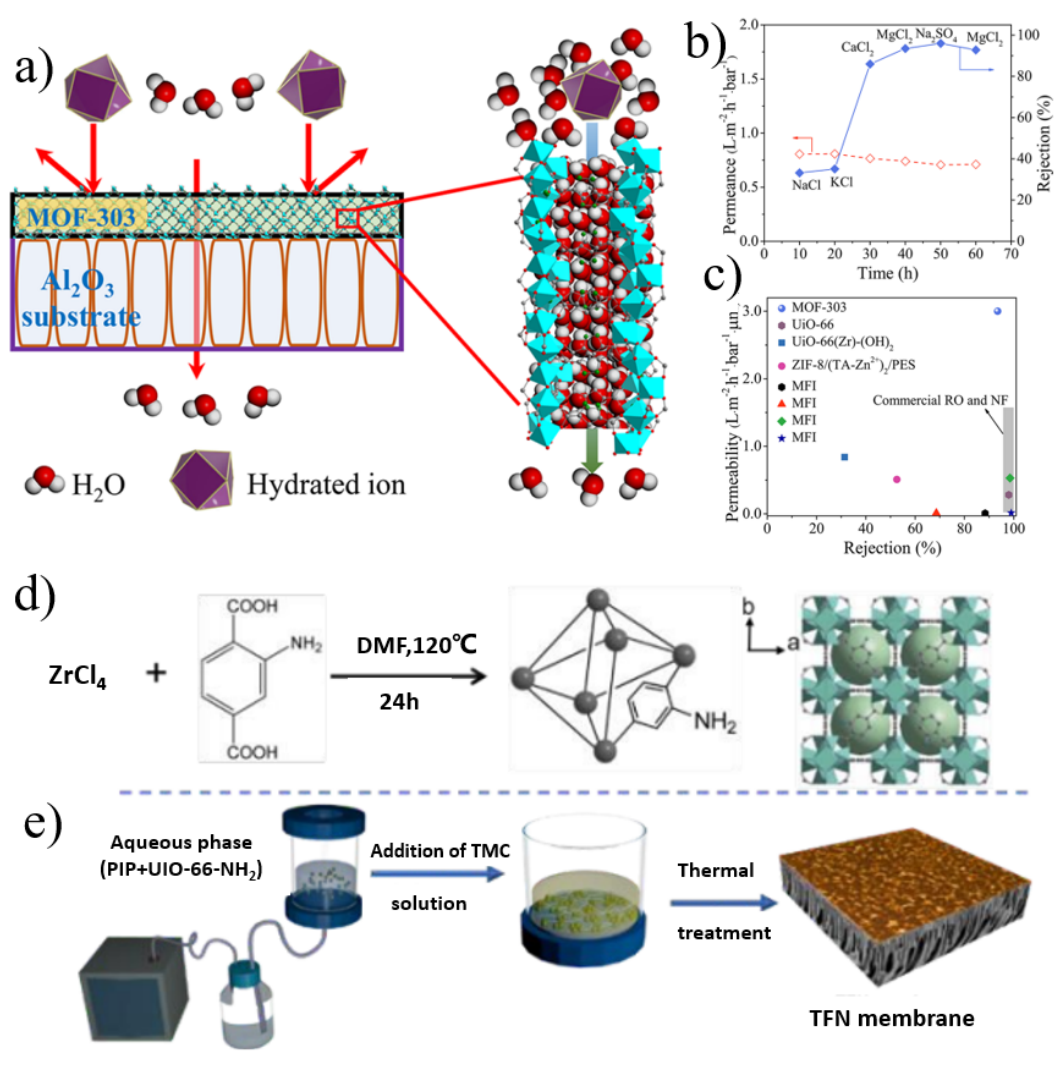
Figure 2. ( a ) Schematic representation of water desalination with a metal − organic framework MOF-303 membrane. ( b ) MOF-303 membrane separation performance for water desalination. ( c ) Desalination (Mg 2+ retention) performances of MOF-303, zeolite, commercial polymeric reverse osmosis (RO), nanofiltration (NF), and other MOF membranes. ( d ) Synthesis of UiO-66-NH 2 nanocrystals. ( e ) Fabrication of thin-film MOF-positioned PA membranes assisted by the filtration of the aqueous phase prior to interfacial polymerization. Reprinted with permission from [28,29]. Copyright (2021) American Chemical Society. Copyright (2019) Royal Society of Chemistry.